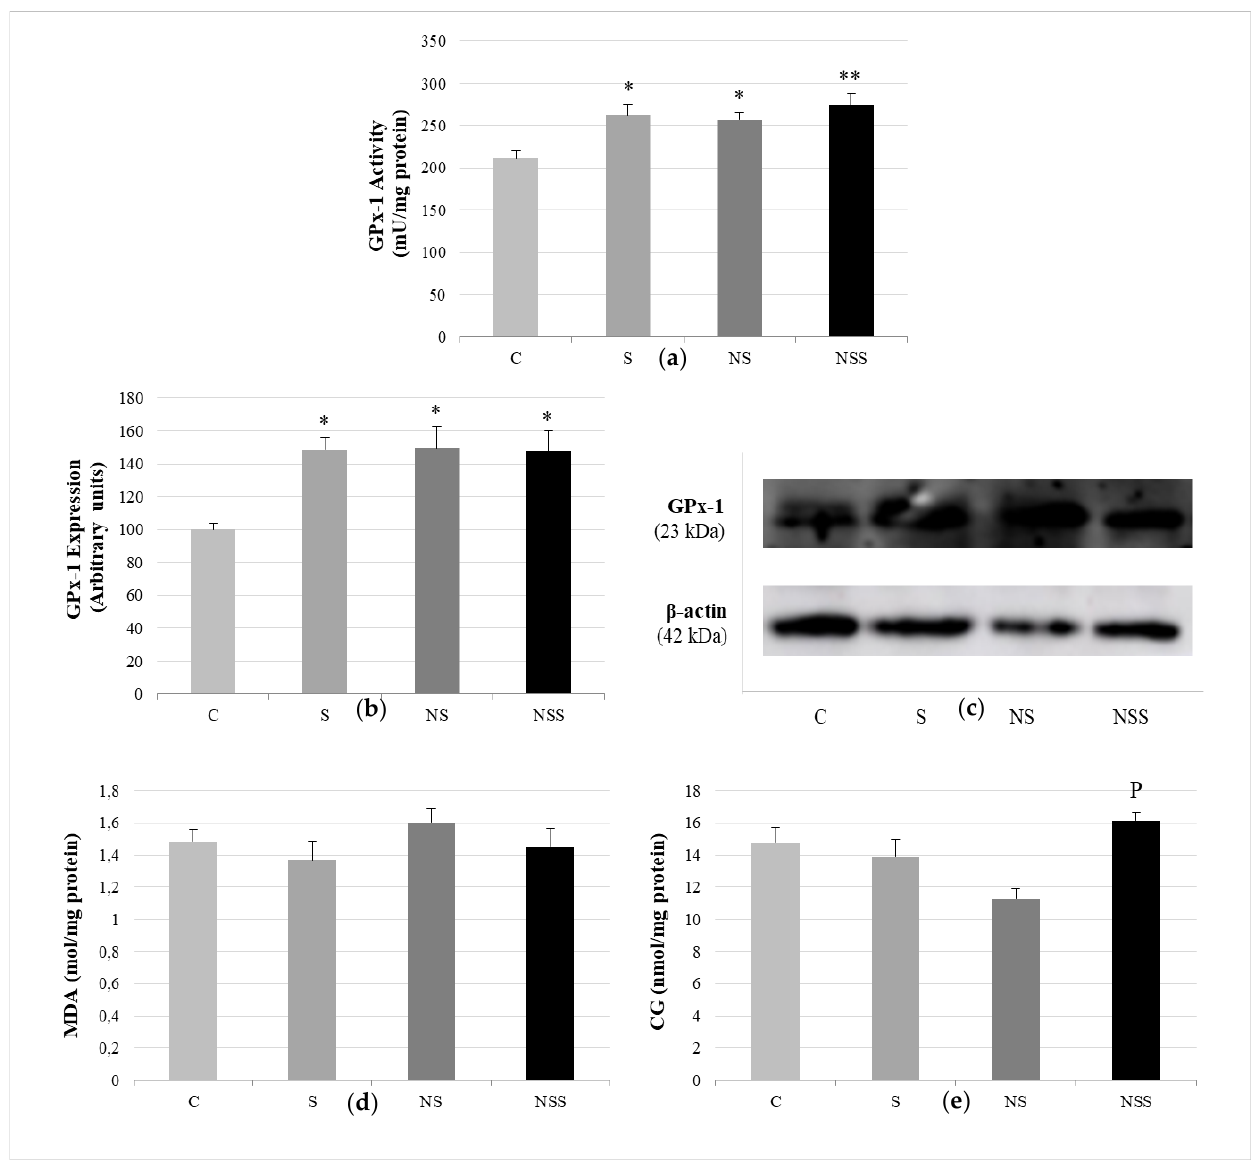
Figure 4. Implication of GPx1 in WAT oxidative balance. Antioxidant activity of GPx-1 ( a ). Expression of GPx-1 (expressed as percent arbitrary relative units, referring to values in control animals, which were defined as 100%) ( b ). Representative Western blot for the expression of GPx-1 and β -actin (as load control) ( c ). Lipid oxidation expressed by the levels of malondialdehyde (MDA) ( d ). Protein oxidation expressed by the levels of carbonyl groups (CGs) ( e ). The results were expressed as means ± SEMs and analyzed using a multifactorial one-way ANOVA followed by Tukey’s test. The number of animals in each group was 6. SEM: standard error of the mean. Groups: C, control group; S, low-selenite group; NS, low-selenite-nanoparticle group; NSS, moderate-selenite-nanoparticle group. Significance: vs. C, * p < 0.05, ** p < 0.01; vs. NP, p < 0.05.